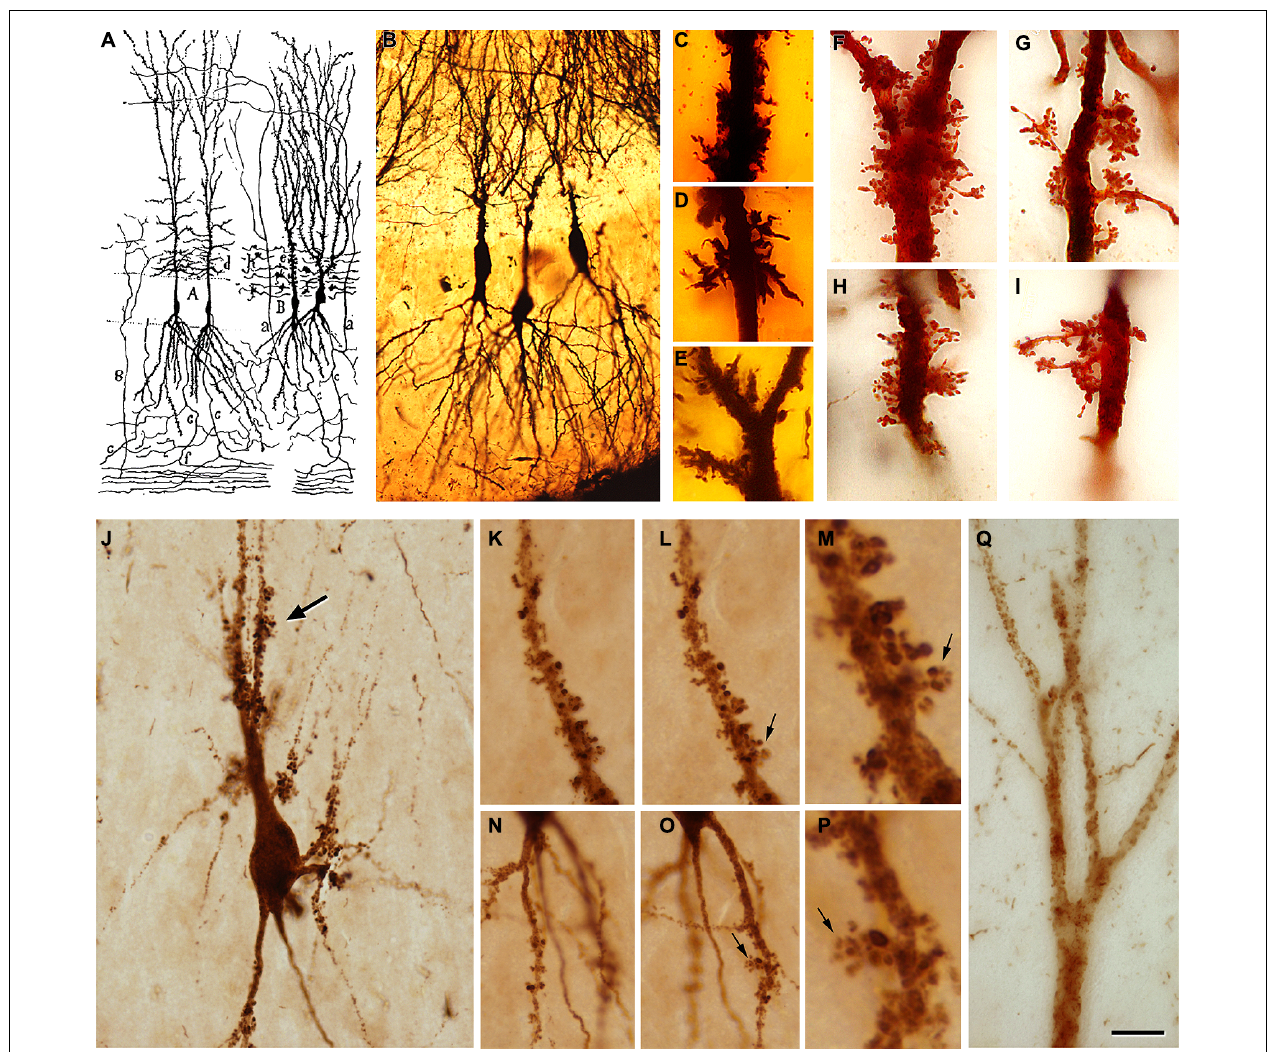
FIGURE 3 | (A) Drawing by Cajal showing pyramidal cells with thorny excrescences in the CA3. (B) , Cajal’s original histological preparations from the rabbit CA3 stained by the Golgi method. (C − I) , Examples of thorny excrescences on CA3 pyramidal neurons. (C − E) , Dendrites from a newborn child’s CA3 pyramidal neurons stained by the Golgi method; (F − I) , Dendrites of rabbit CA3 pyramidal neurons stained by the Kenyon’s variant of the Golgi method (preparations housed at the Cajal Institute).Thorny excrescences were named and discovered by Cajal in the apical dendrites of rabbit CA3 pyramidal neurons (Estructura del asta de Ammon y fascia dentata. Anales de la Sociedad Española de Historia Natural , tomo XXII, 53–114, 1983). He correctly proposed that these large and often branched structures served as points of contact with the mossy fibers from the dentate gyrus.The presence of excrescences was later confirmed in a variety of species,